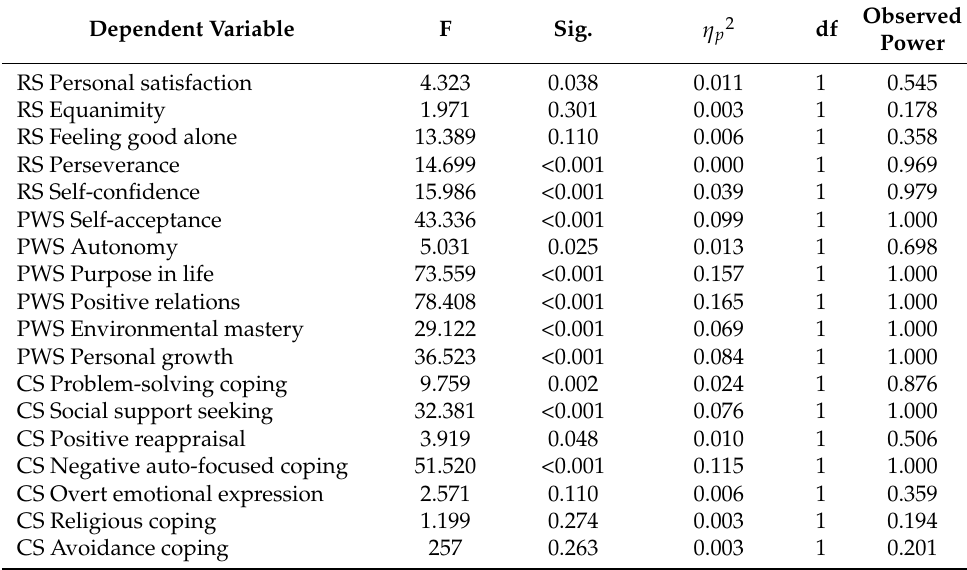
Table 6. Effects tests between subjects: health status.